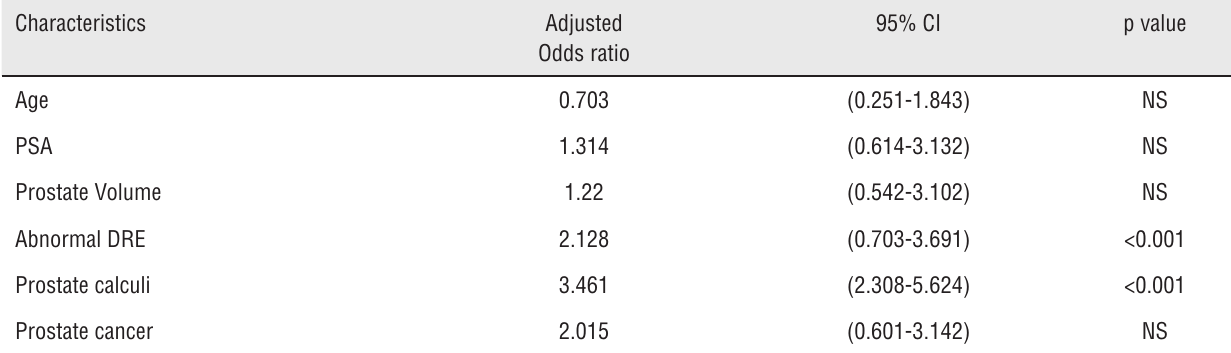
Table 3 - Results of multiple logistic regression analysis examining the correlation between clinicopathological variables and hematospermia risk after prostate